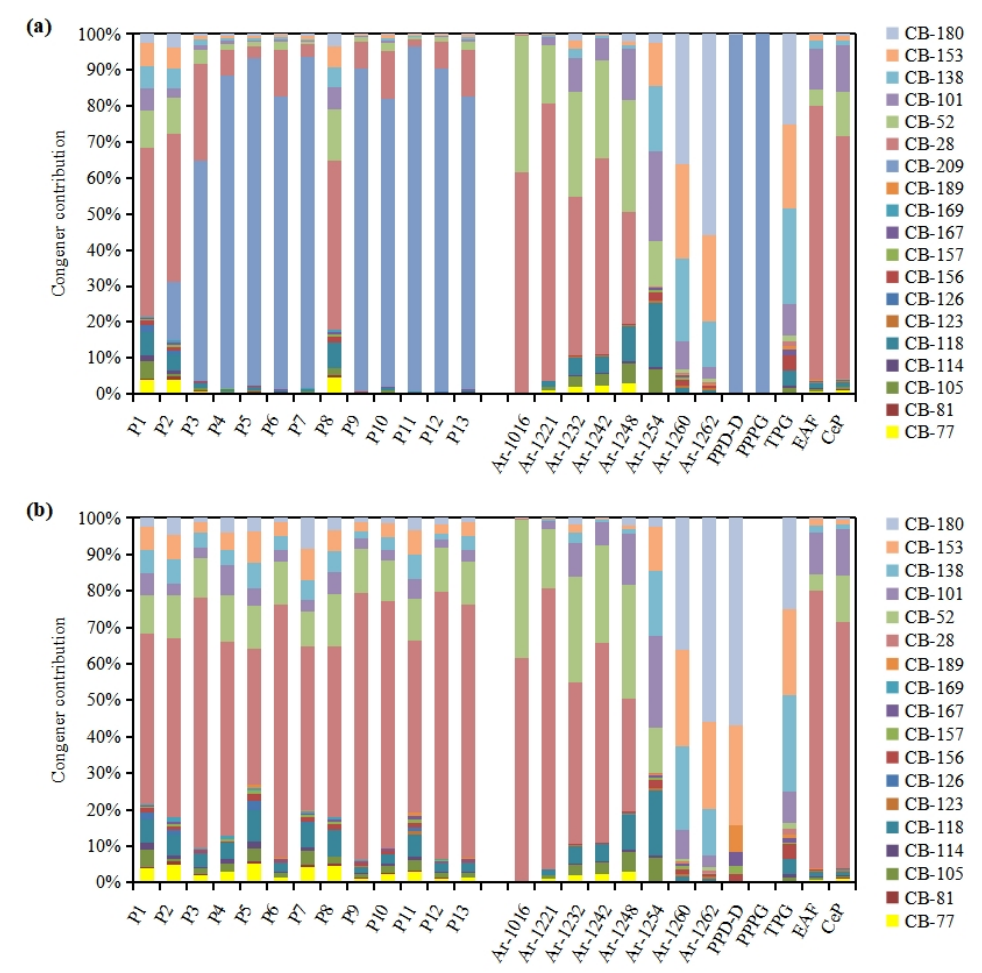
Figure 2. PCB patterrns with ( a ) and without CB-209 ( b ) in soil samples of the present study, commercial PCB formulations (Ar-1016, 1221, 1232, 1242, 1248, 1254, 1260, 1262) [32], phthalocyanine green pigments (PPD-D and PPPG) [6,33], a titanium pigment (TPG) [34] and stack gas from steel smelting (EAF) and cement kiln (CeP) [35] (only CB-209 were detected in PPPG according to the congeners reported).